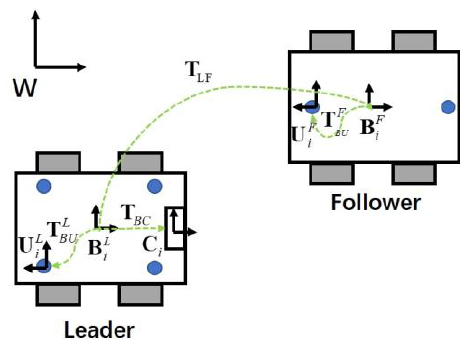
Figure 1 . The frame definition of the Leader and Follower ： the world frame is W ; the AGV base frame (IMU frame) is B ; the camera frame is C ; the UWB frame is U; the transformation of Leader and Follower is T LF